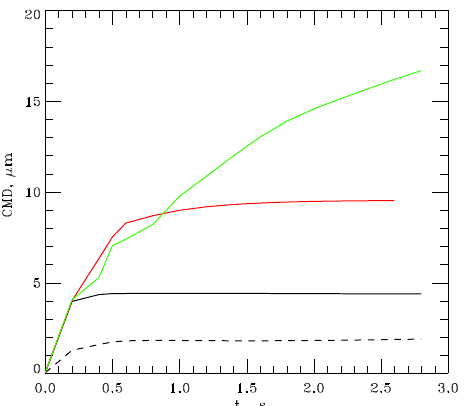
Figure 11. The dependence of supersaturation averaged over the calculation domain on time for case 1 (green solid curve), case 2 (red solid curve), case 3 (black solid curve), case 4 (black dashed curve). Horizontal lines show the corresponding values of S init /e . Asterisks show the extrapolation function in case 1 (see Eq. 6).